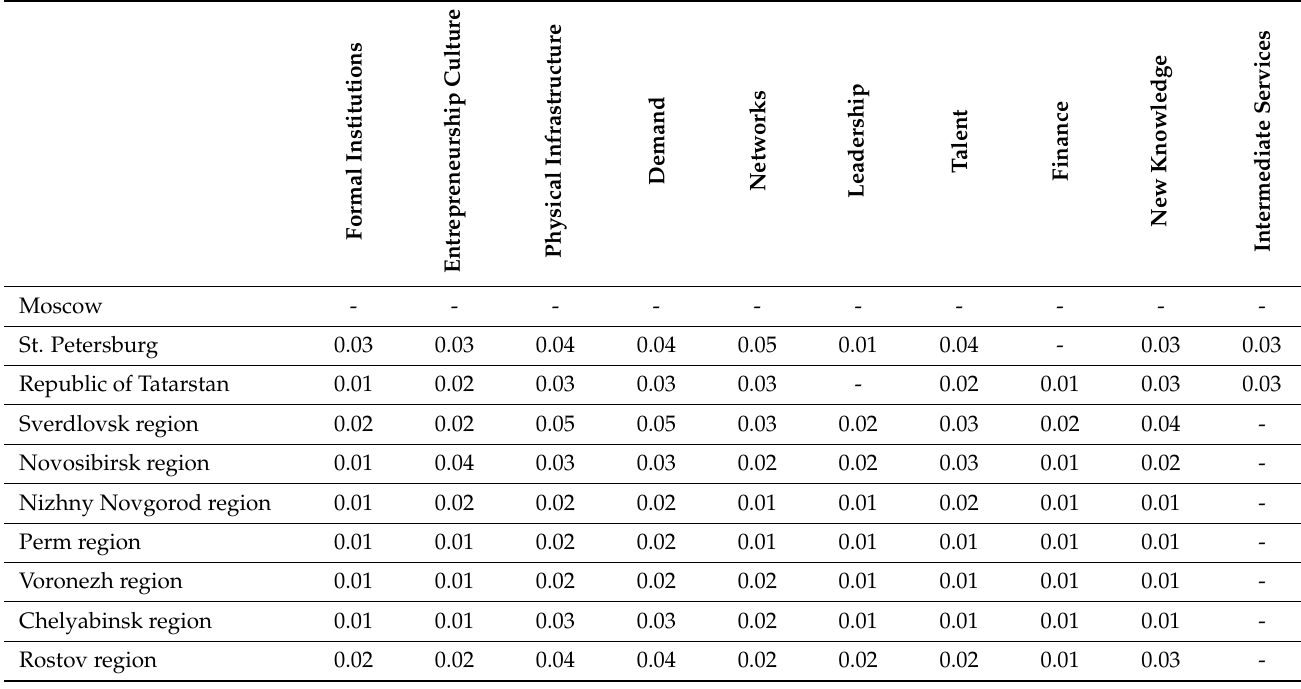
Table 8. The slack of inefficient Russian